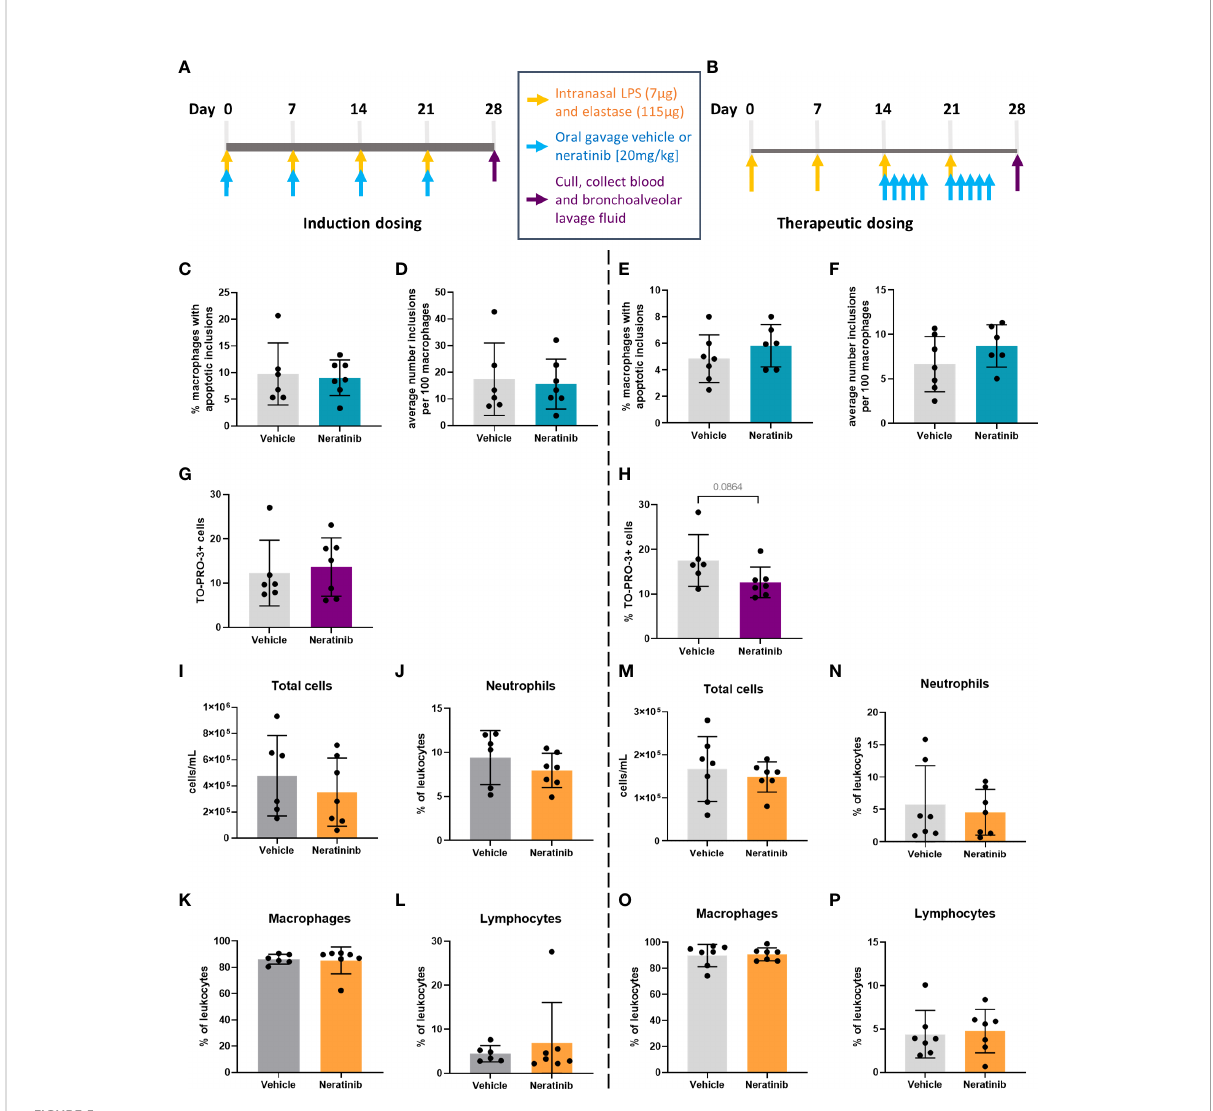
FIGURE 5 No changes in efferocytosis or cell corpse numbers were observed with neratinib treatment in chronic models of lung disease. Two different dosing protocols were used for neratinib treatment in the chronic lung disease model: induction dosing (A) and therapeutic dosing (B) . Uptake of cell debris by macrophages was unchanged between treatment groups in both the induction dosing (C, D) and therapeutic dosing (E, F) models. The percentage of TO-PRO-3+ cells in BAL, assessed by fl ow cytometry, was unchanged in the induction dosing model (G) and the therapeutic dosing model (H) . Leukocyte number in BAL and the percentage of neutrophils, macrophages, and lymphocytes were similarly unchanged across both models (I – P) . Each data point in graphs represents data from one mouse; bars show mean ± standard